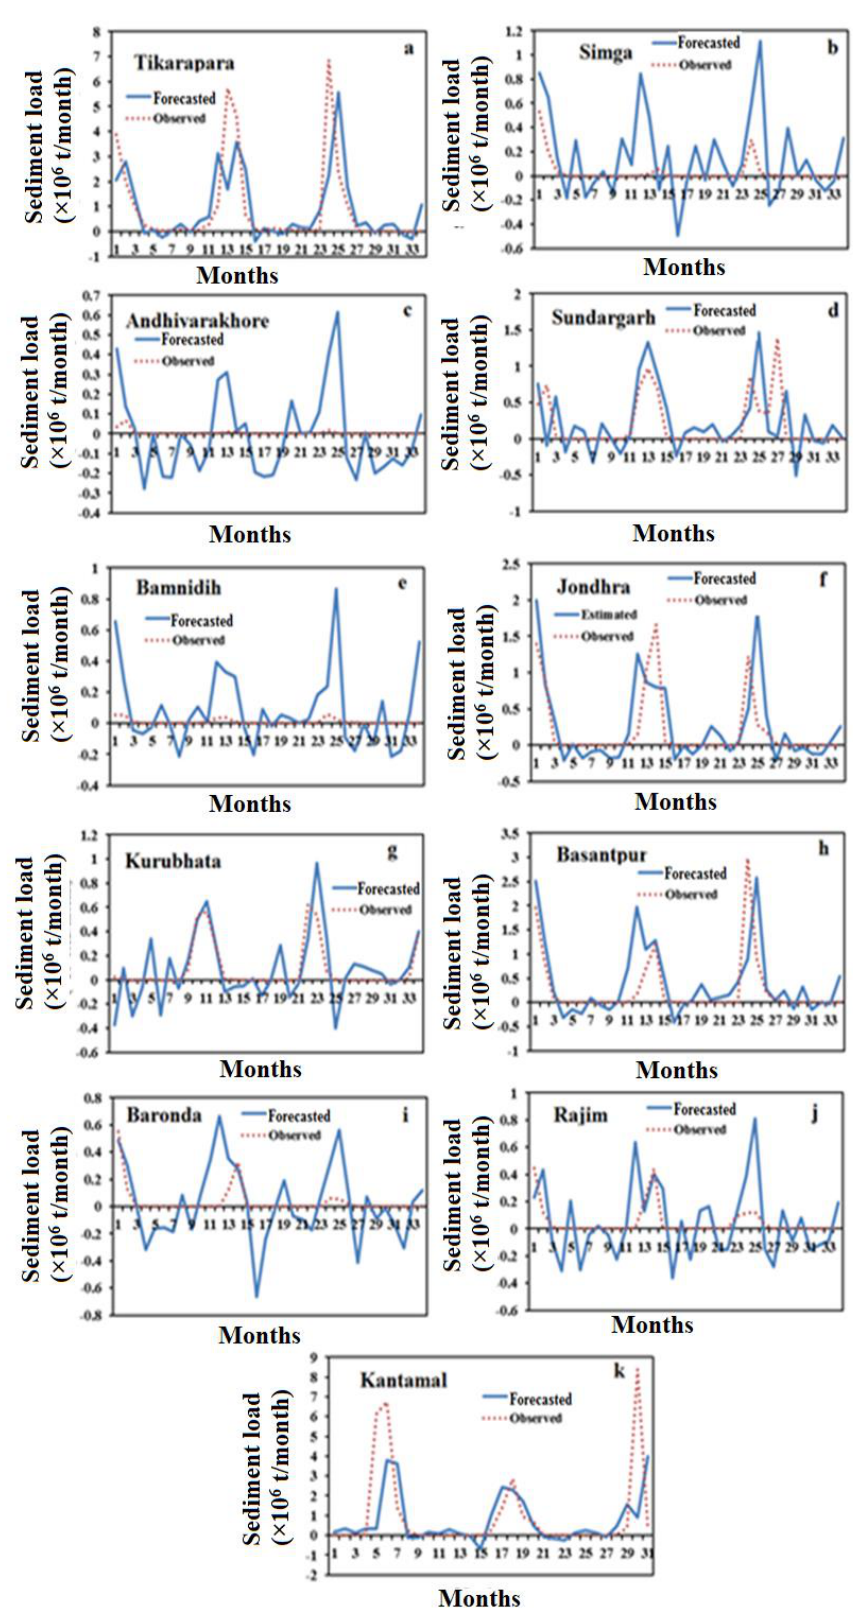
Figure 11. Comparison of the actual and forecasted SL during the testing phase of the MAR forecasting model (a-k).